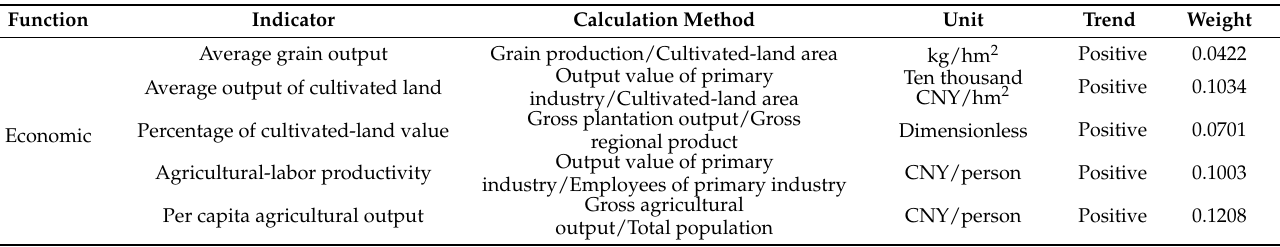
Table 2. Indices for assessing cultivated-land functions. The overall per capita grain demand was determined as 400 kg per person per year [32]; the safety standard for chemical-fertilizer application followed the international chemical fertilizer application safety standard of 225 kg per hectare [33]; the degree of fragmentation of cultivated land was represented by the ratio of the number of cultivated-land patches to defined area, which was calculated based on an ArcGIS platform; the ecological value of cultivated land was calculated by referring to the ecological service value coefficient table compiled by Xie et al. [34].